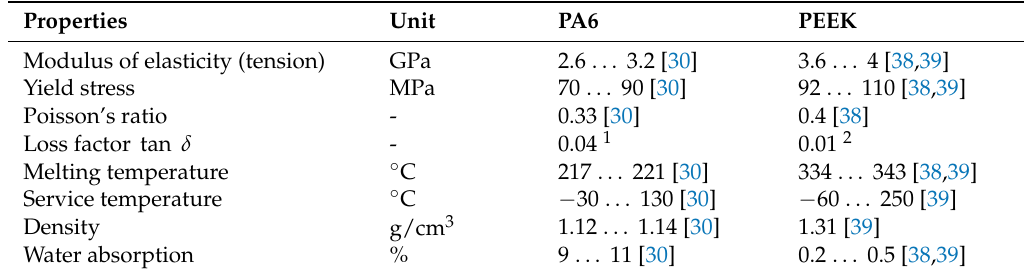
Table 1. Properties of dry polyamide (PA6) and polyether ether ketone (PEEK) at 20 ◦ C.